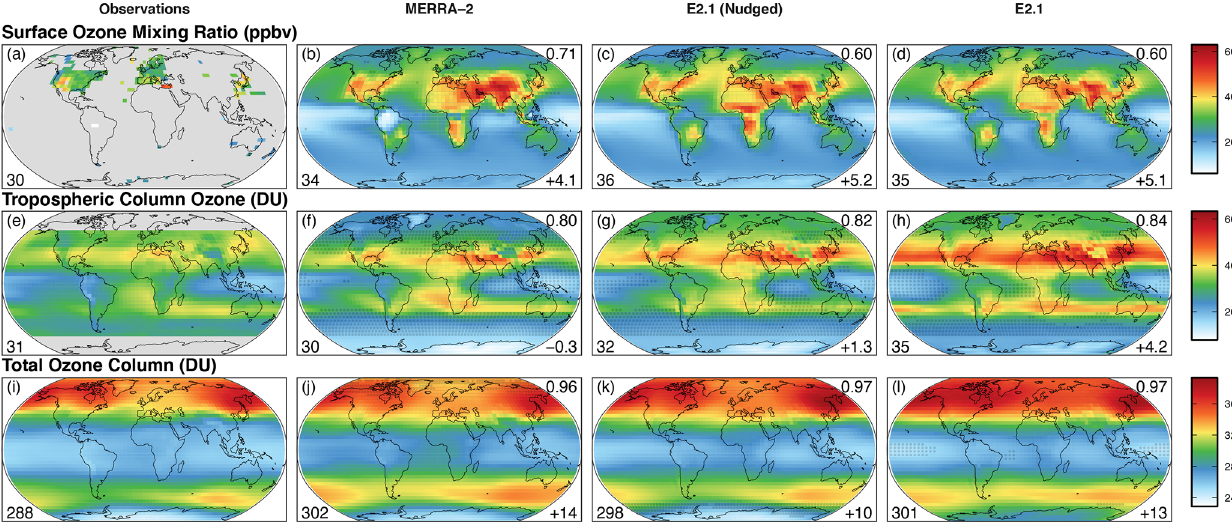
Figure 17. Annual average surface ozone mixing ratio in ppbv ( ≡ nmolmol − 1 ; top row), tropospheric columns of ozone (TCOs; in Dobson units; middle row), and total ozone columns (TOC; in Dobson units; bottom row) for 2005–2014CE. The left column from top to bottom shows observations from TOAR (Schultz et al., 2017a), OMI/MLS (Ziemke et al., 2006) and OMI (Dobber et al., 2006), respectively. The three columns on the right show equivalent values determined from GEOS-Chem driven by MERRA-2, E2.1 nudged to MERRA-2, and free-running E2.1 meteorology. Gray dots show locations where the simulated values are statistically different from the observations with respect to interannual variability ( p value < 0.05; n = 10 years). The number in the lower left of each panel shows the global mean value. The number in each model panel’s top right shows the pattern correlation ( R ) between the simulated and observed values. The number in the lower right shows the mean bias of the model with respect to the observations. The tropopause was determined in the simulations using the thermal lapse rate for comparison with satellite tropospheric products.